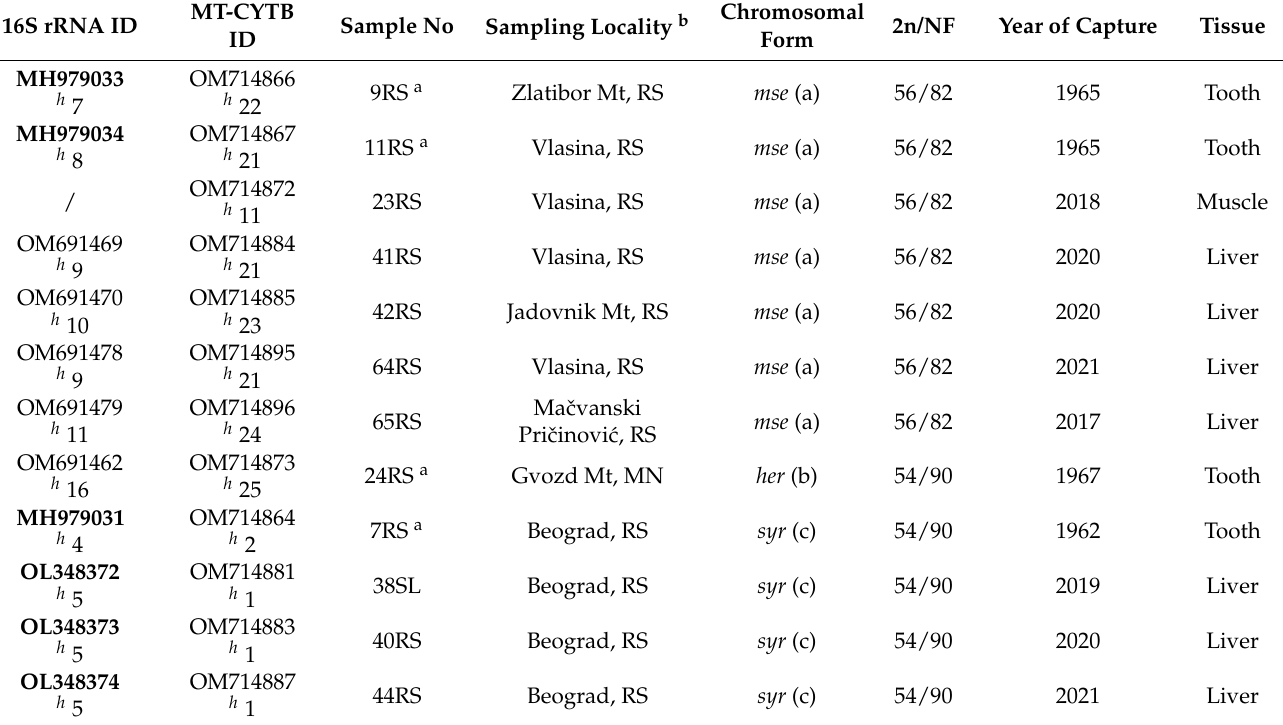
Table 1. A list of 40 N. leucodon samples, with IDs (GenBank accession numbers) for mtDNA gene sequences. IDs shown in bold were published previously [35,45]. 2n—diploid chromosomal numbers; NF—fundamental number of chromosomal arms. See Figure 1 for abbreviations of chromosomal forms and their sampling localities (letters in